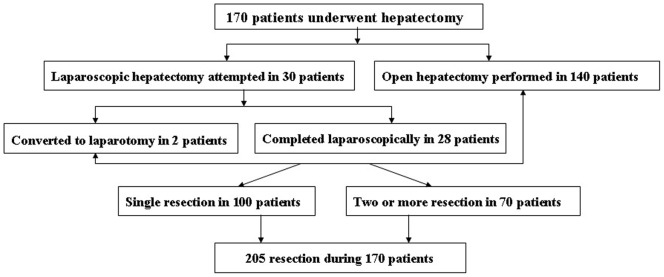
Flow chart of attempted hepatectomy.